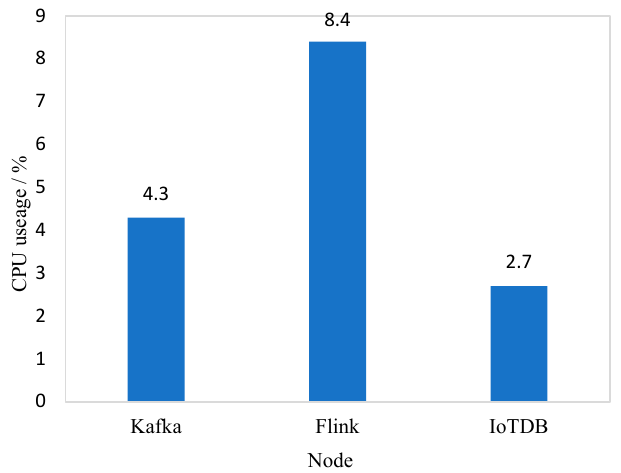
Figure 8. CPU usage of each node under the real dataset.